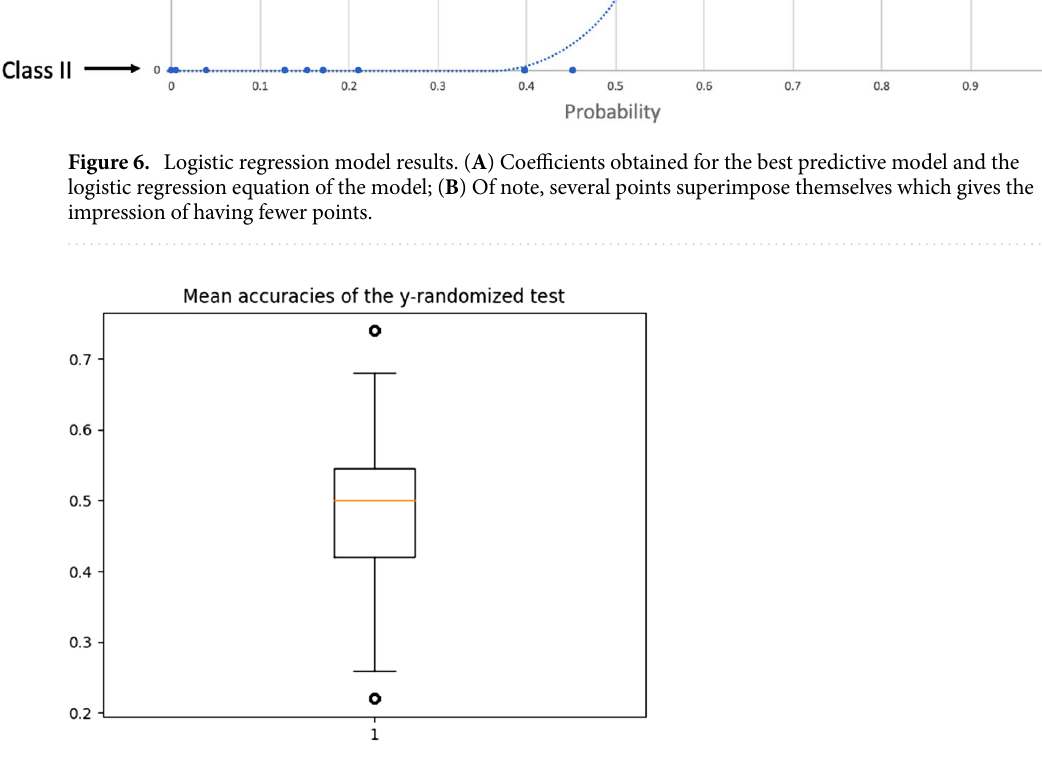
Figure 7. Randomized process results. Mean accuracy boxplot resulting from the accurracies obtained by the y-randomized